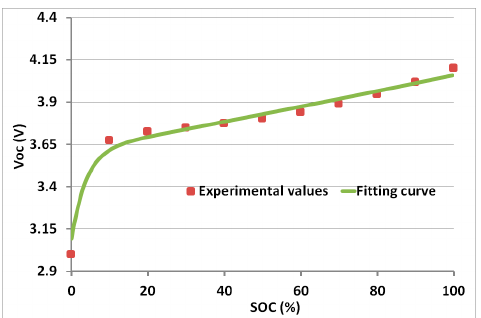
Figure 4. Experimental and fitting result of (cid:1848) (cid:2197)(cid:2185) versus state of charge ( SOC) .